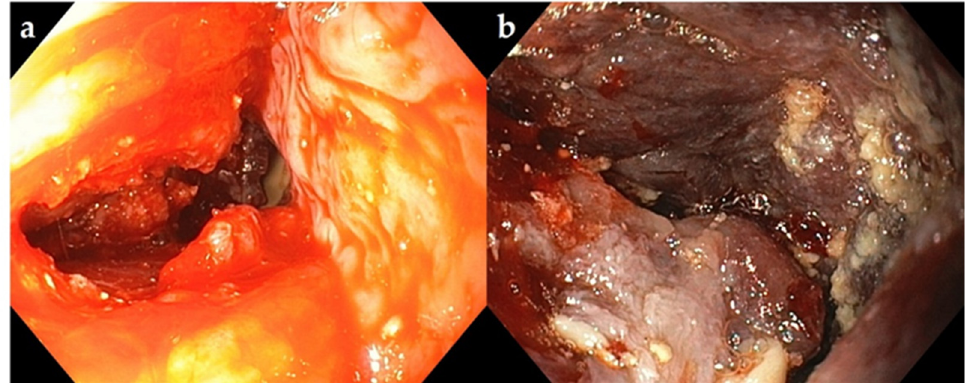
Figure 4. Endoscopic view of the pharyngeal abscess cavity ( a ) before and ( b ) after manual drainage and lavage.